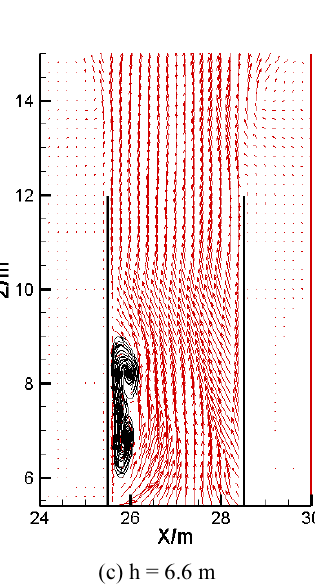
Fig. 8. Velocity vector field in the shaft (the connection angle